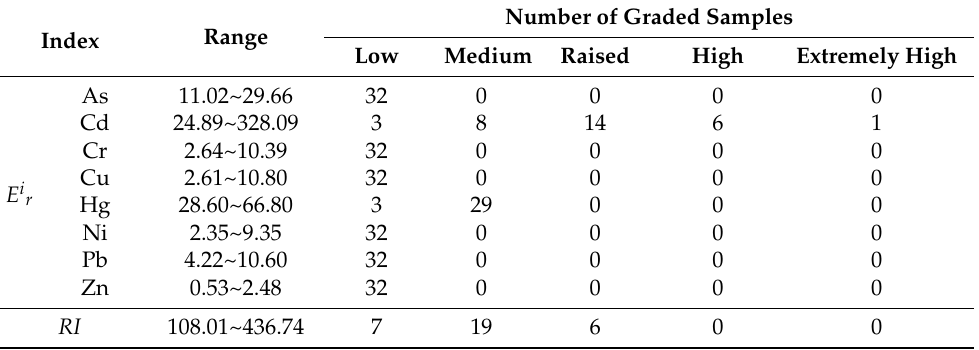
Table 7. Classification statistics of potential ecological risk index of heavy metals in the soil of the karst area.